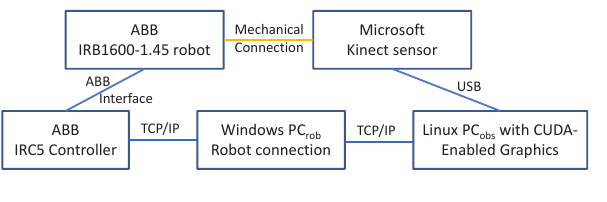
Figure 3: Overview of system components.